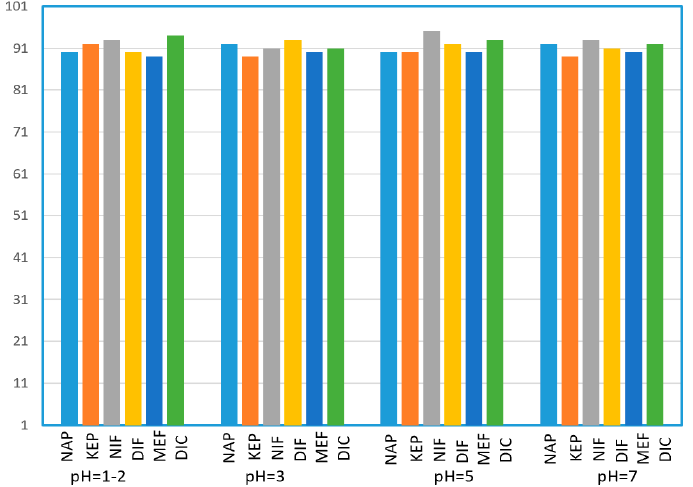
ff ects of sample pH on the recoveries (%) of selected pharmaceuticals, n = Figure 5. Effects of sample pH on the recoveries (%) of selected pharmaceuticals, n = 3. Figure 5. E